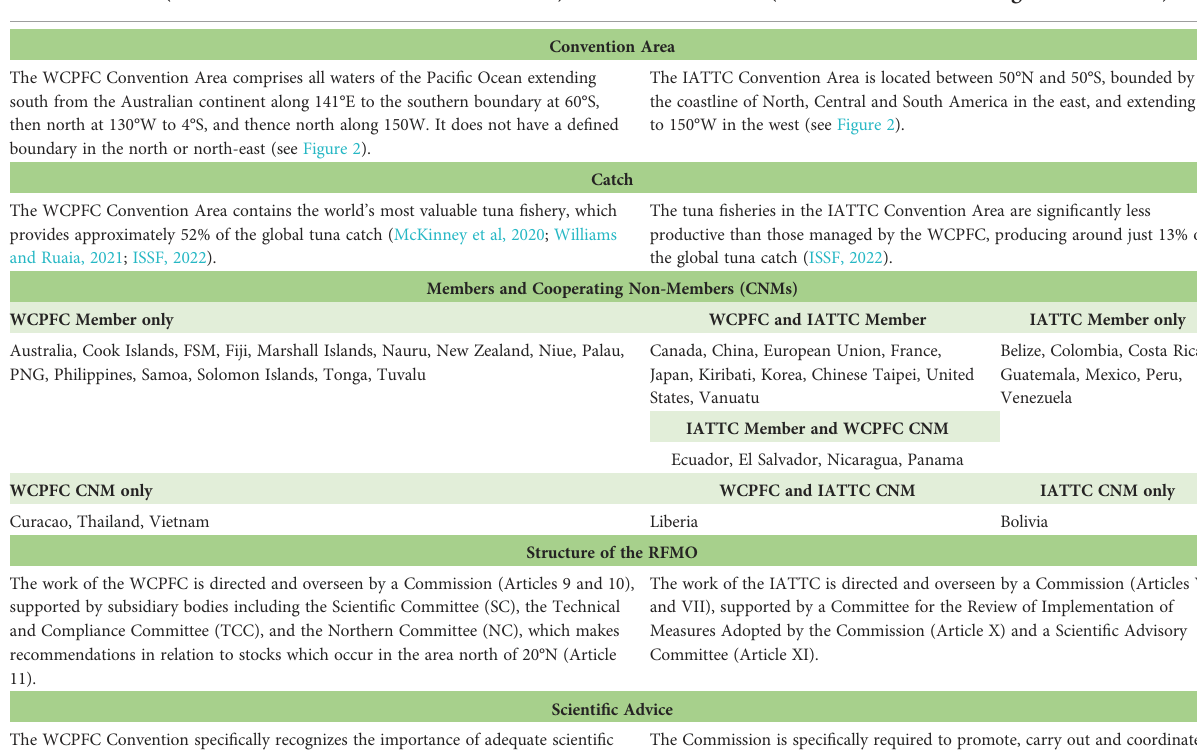
TABLE 2 Key features, provisions and measures of WCPFC and